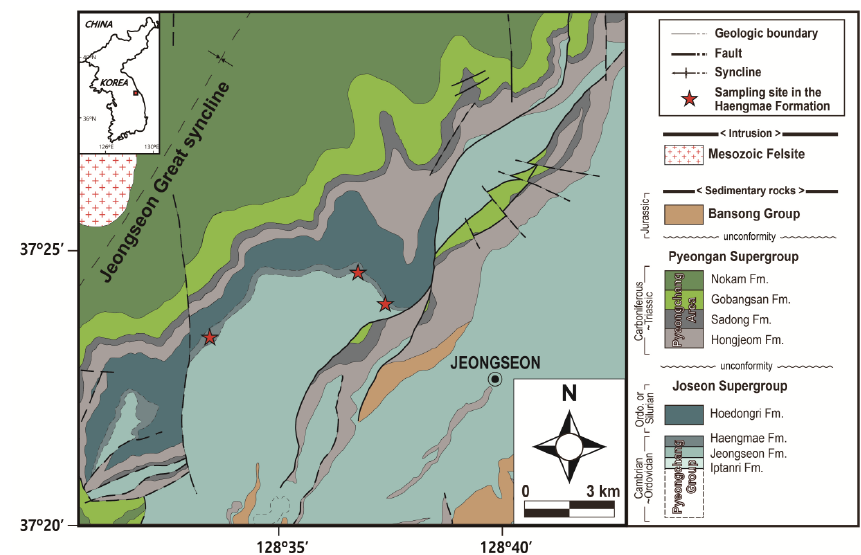
Figure 1. Regional geological map showing the northwestern Taebaeksan Zone of South Korea (modified after [22]). Stars indicate the sampling site in Haengmae Formation.